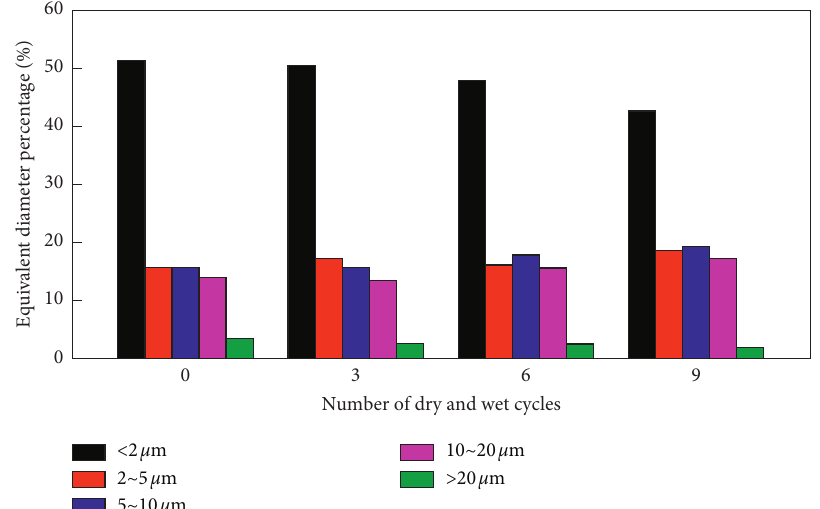
Figure 21: Equivalent diameter percentage distribution of soil particles under different drying-wetting cycles.